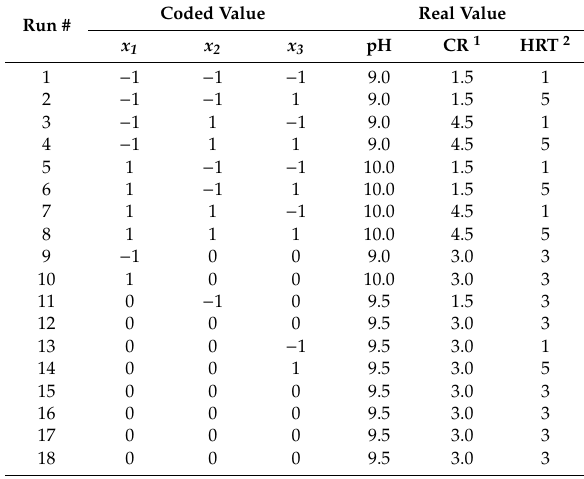
Table 3. The central composite design with coded and real values for three independent variables. Coded Run #